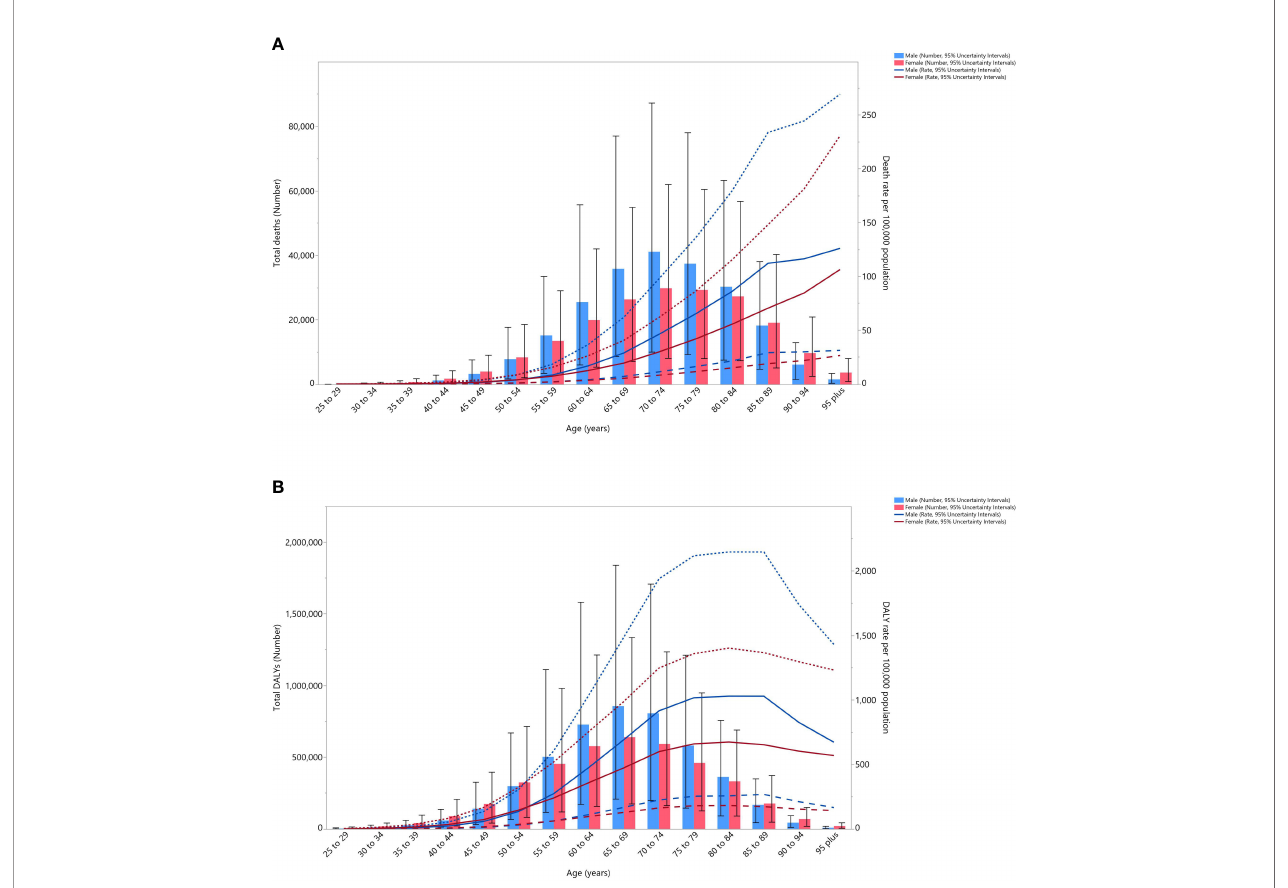
FIGURE 3 | Global number of deaths and death rate (A) and global number of DALYs and DALY rate (B) of cancers attributable to high fasting plasma glucose (per 100,000) by age and sex in 2019; Dotted and dashed lines indicate 95% upper and lower uncertainty intervals, respectively. DALY= disability-adjusted-life-years. (Generated from data available from